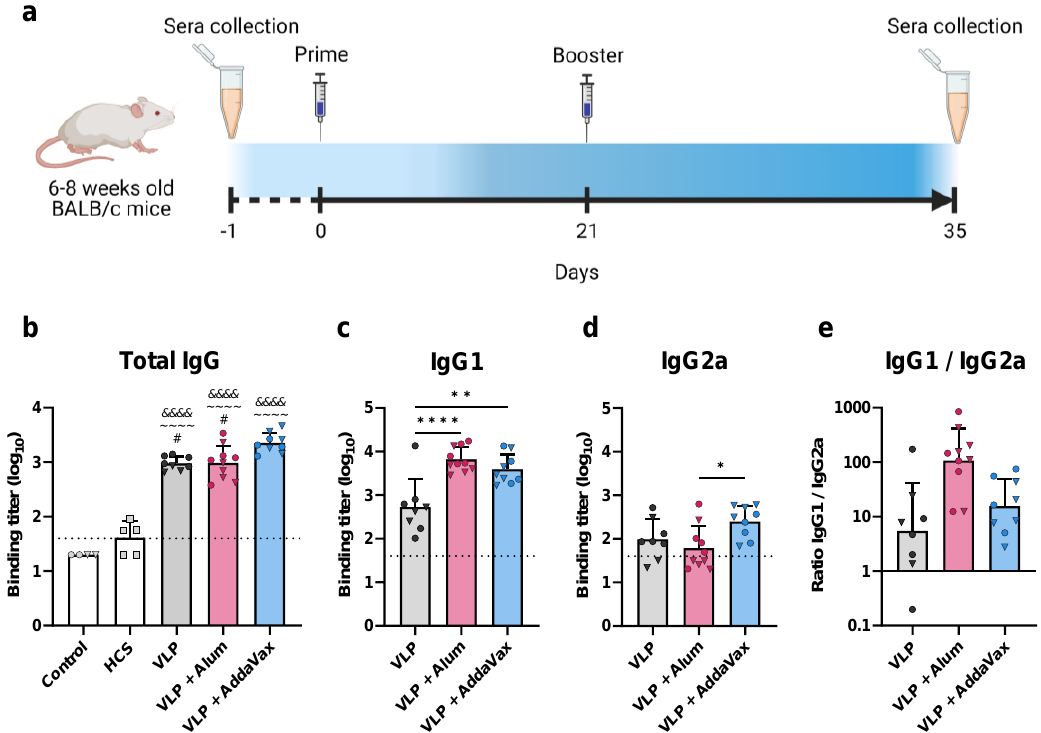
Figure 2. Mouse vaccination schedule and assessment of immunogenicity via ELISA. ( a ) Immunization schedule for mice vaccinated with the monovalent (Beta) VLP vaccine. Groups of mice ( n ≥ 8) were immunized with the monovalent VLP vaccine alone (VLP), or adjuvanted with aluminum hydroxide (alum) or AddaVax. Prime and booster immunizations were administered on days 0 and 14, respectively. Serum samples were collected prior to immunization (day − 1 ) and three weeks after the booster immunization (day 35). ( b – e ) Sera were assessed by ELISA for Spike-specific antibodies using plates coated with the Wuhan-Hu-1 Spike protein. Binding titer represents the dilution at which sera showed half of their maximal binding activity. Binding titers for individual animals are presented as either circles ( ● ) for females or triangles ( ▼ ) for males. Dotted line indicates lower limit of detection. ( b ) Total IgG levels were measured for all vaccinated mice and compared to human convalescent sera (HCS) and sera collected from mice prior to immunization (Control). Spike-specific ( c ) IgG1 and ( d ) IgG2a were measured in vaccinated mice. ( e ) Ratio of IgG1 to IgG2a. Data are mean + SD in ( b – d ), and geometric mean + geometric SD in ( e ). Results were analyzed by one-way ANOVA with Tukey’s multiple comparisons test, with P < 0.05 considered significant. * P < 0.05, ** P < 0.01, **** P < 0.0001. In ( b ), ampersands (&) indicate comparisons with Control, tildes (~) indicate comparisons with HCS, and pound signs (#) indicate comparisons with the VLP + AddaVax group. In ( c – e ), statistical comparisons are represented with asterisks above lines connecting the compared groups.